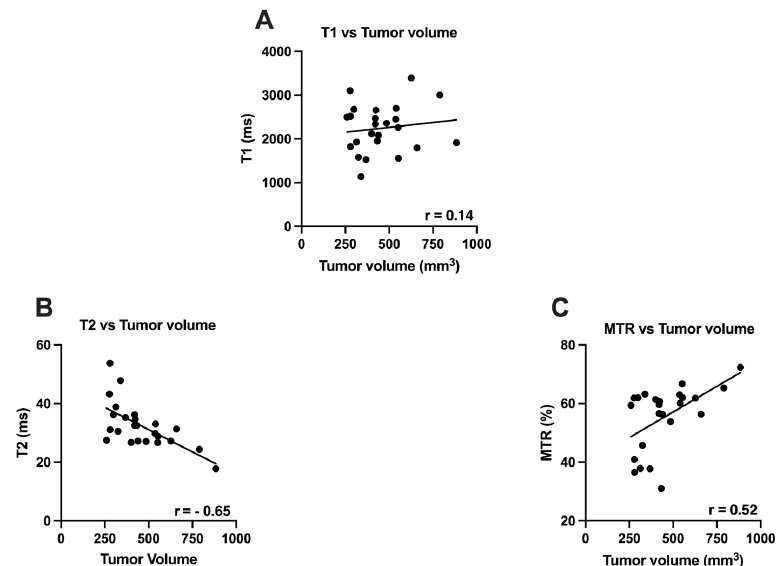
Figure 1. Relationship between Tumor volume and MR parameters in advanced stages of PDAC. ( A ) showing relationship between Tumor volume and T1 (ms); ( B ) showing relationship between Tumor Volume and T2 (ms); ( C ) showing relationship between Tumor volume and MTR (%).